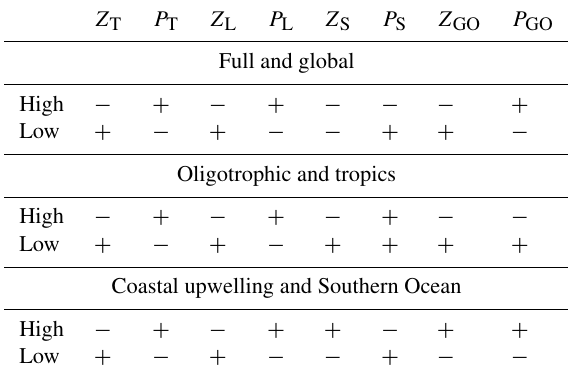
Table 1. Qualitative comparison of the response of total, large and small zooplankton ( Z T , Z L , Z S ) and phytoplankton ( P T , P L , P S ) to a 50% higher and lower zooplankton mortality parameter in our experiments B, with the results from Getzlaff and Oschlies (2017) ( Z GO , P GO ). Full, oligotrophic and coastal upwelling refer to the regions in our study (see Fig. 1) integrated over the upper 100m; global, Southern Ocean and tropics refer to the study by Getzlaff and Oschlies (2017, their Figs. 2 and 3 at year 300). We grouped to- gether global and full because both refer to the whole model domain in each of the two studies. Similarly, oligotrophic and tropics refer to regions characterised by low nutrient concentrations, and coastal upwelling and Southern Ocean are both regions with high nutrient